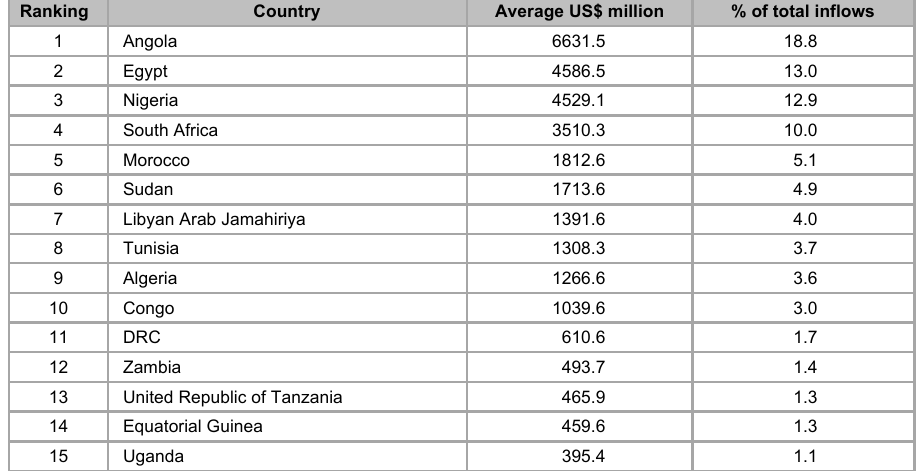
Ranking of top 15 FDI recipients and share of inflows, 2000-2008 Country Average US$ million % of total